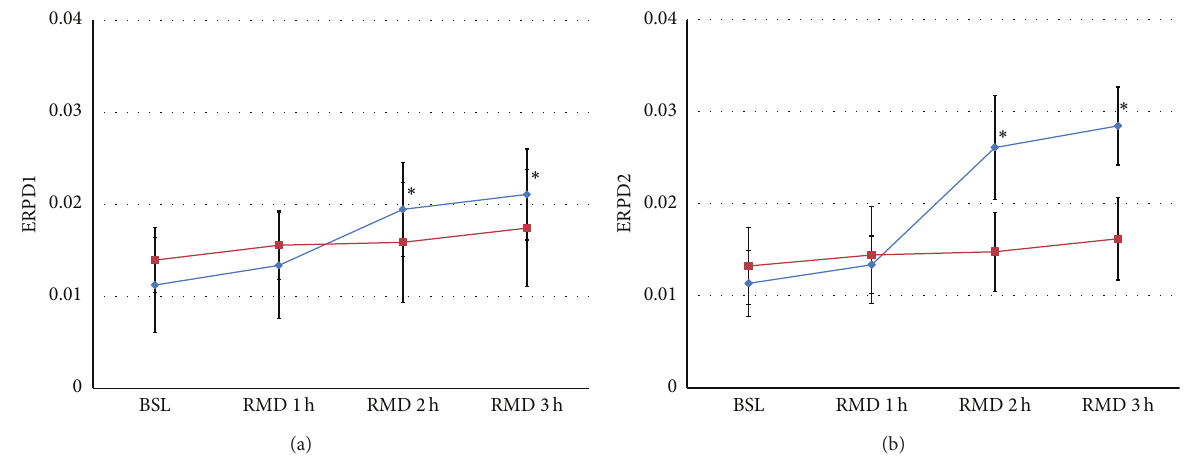
Figure 5: Effects of LLVNS on ERP dispersion. LLVNS reversed the effects of RAP on ERP dispersion. The blue ( ⬦ ) and red ( ◻ ) curves represent the control group and experimental group, respectively. The symbols and abbreviations are the same as those in Figure 3.